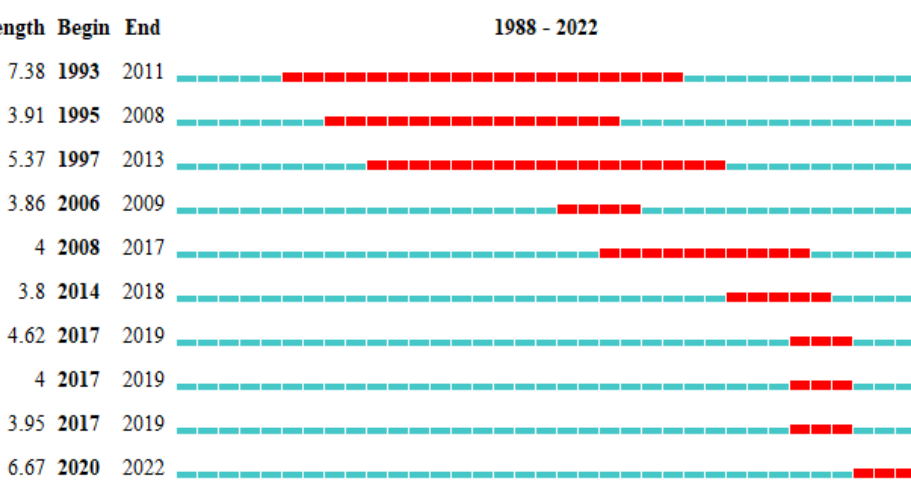
Figure 10. Top 10 keywords with the strongest citation bursts.